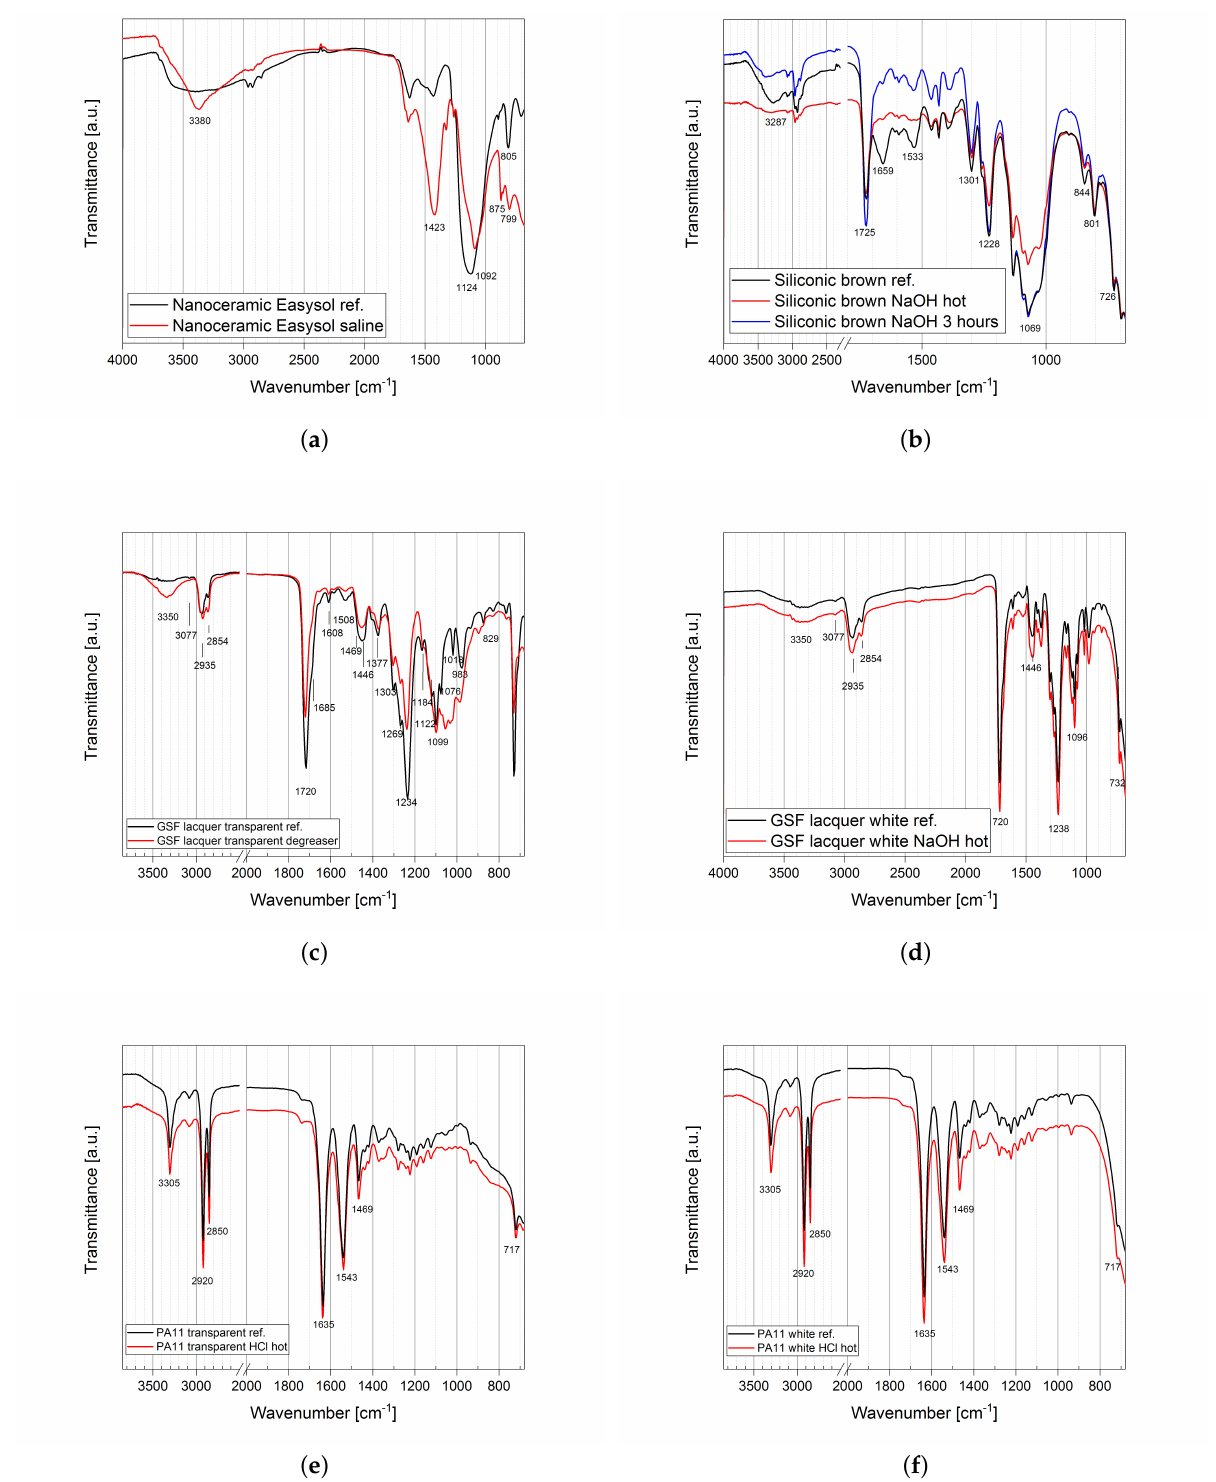
Figure 4. ATR spectra of sample before and after contact with chemicals at different levels of aggressivity to highlight corrosion or inertness of the coatings: ( a ) damages on the transparent nanoceramic coating by the saline solution; ( b ) brown siliconic coating showing slightly different spectra; ( c , d ) transparent and white thick GSF lacquers showing that the basic degreaser corroded the transparent coating but not the white one; ( e , f ) transparent and white PA11 samples showing no difference between the spectra of the reference and of the spots in contact with hot 4M HCl